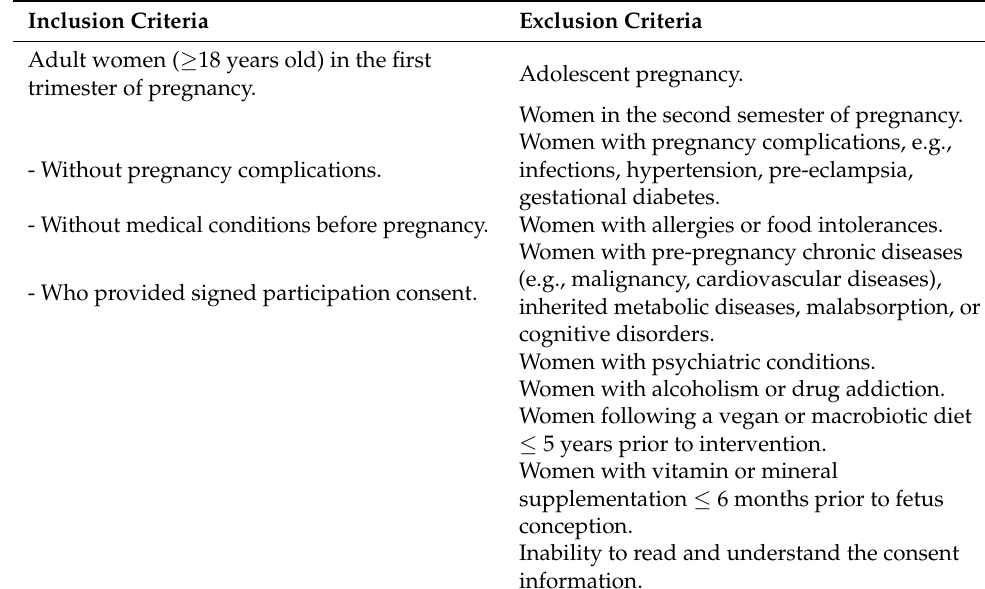
Table 1. Inclusion and exclusion criteria for study